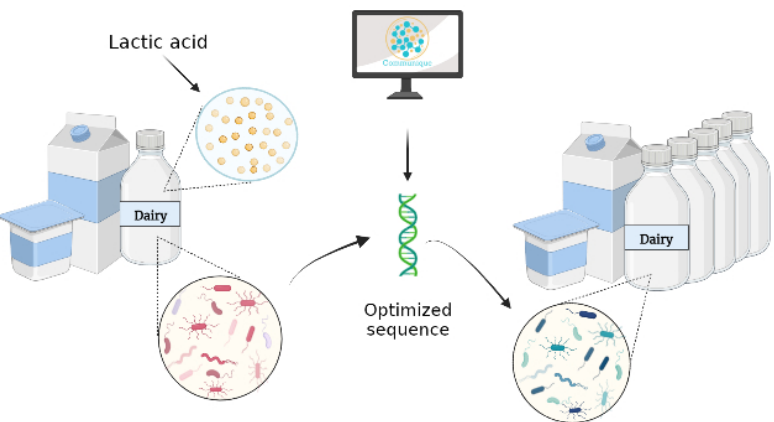
Figure A6. Detecting specific substances in the soil using the algorithm. The optimized gene is inserted to the bacteria, the combination of the gene with the TNT causing bio ‐ reaction, and the TNT can be detected.